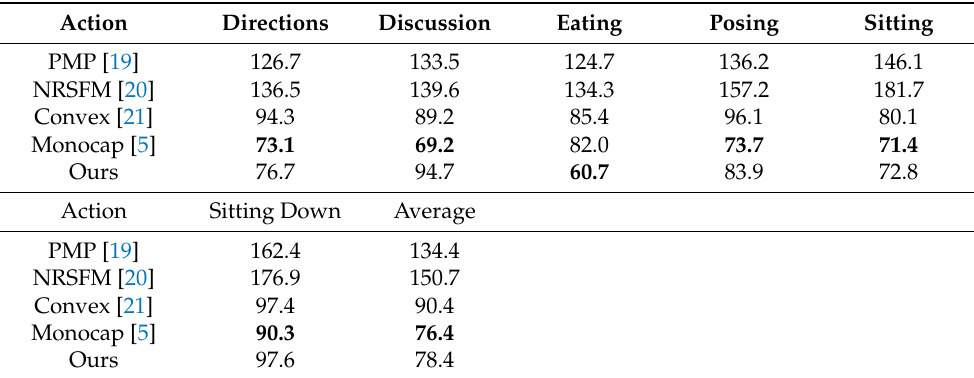
Table 6. MPJPE of the algorithms given 2D keypoints (mm) (Bold indicates highest